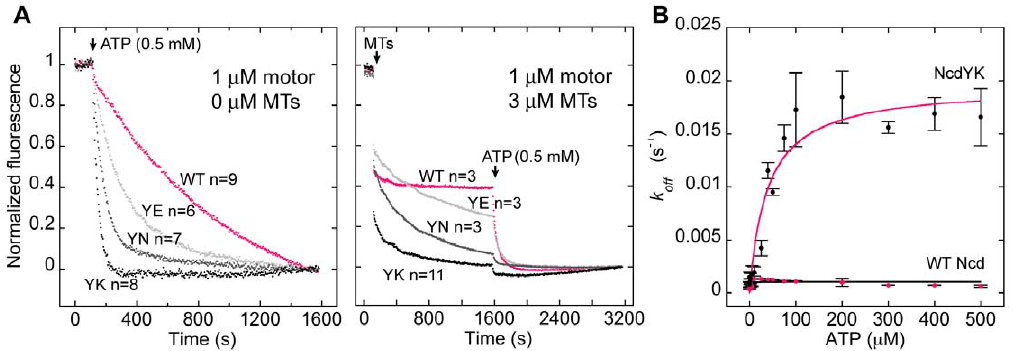
Figure 2. ADP release by the NcdY485 mutants. (A) ADP release without (left) and with microtubules (right). Normalized mean fluorescence versus time after adding ATP (left, arrow) or microtubules followed by ATP (right, arrows) to motor bound to mant-ADP. WT, wild type (magenta). Mutants, YE (gray); YN (dark gray); YK (black). s, seconds. (B) NcdY485K ADP release after adding 0–0.5 mM ATP to 1 m M motor bound to mant-ADP. k off (s 2 1 ) per active site vs [ATP]. WT (magenta circles; curve fit, black); NcdYK (black circles; curve fit, magenta). Data points fit to the Michaelis-Menten equation to estimate V max and K M,ATP . Error bars, mean 6 SEM. Assays performed in HEM100. doi:10.1371/journal.pone.0047148.g002 YK . YN . YE . WT (Figure 2A, right), the same order as ADP release without microtubules. NcdY485K binds ATP with much lower affinity than wild type The absolute fluorescence decrease for NcdY485K was only , 50% as much as wild-type Ncd or the two other mutants (Figures S1 and S2), presumably due to lower nucleotide affinity than the other motors. We tested the possibility that NcdY485K binding affinity for ATP was lower than wild type by performing ATP-induced mant-ADP release assays to measure the Michaelis constant for ATP, K M,ATP . The NcdY485K K M,ATP was , 60-fold higher (mean 6 SEM, 40 6 11 m M, n= 3–4) than wild type (0.7 6 0.5 m M, n= 2) (Figure 2B and Table 1), indicating much lower affinity for ATP; the V ma x per active site for NcdY485K ADP release (0.020 6 0.001 s 2 1 , n= 3–4) was , 20-fold greater than wild type (0.00103 6 0.00009 s 2 1 , n= 2), consistent with the much faster ADP release observed in the previous assays. The NcdY485K mutant thus binds ATP with much lower affinity than wild type and releases ADP much faster.